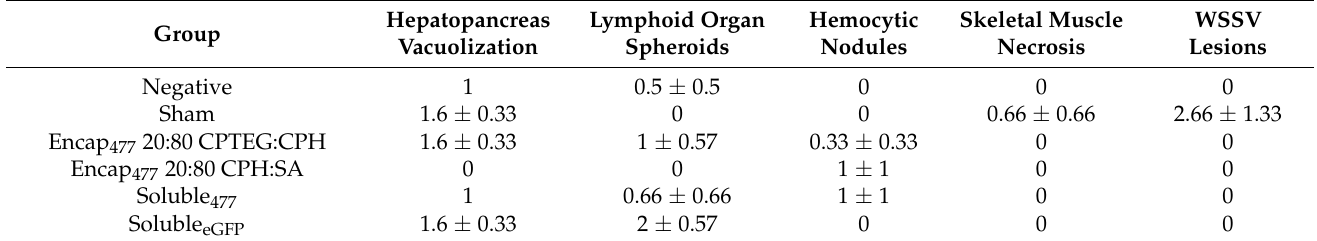
Table 5. Severity grade of necrosis and lesions caused by WSSV